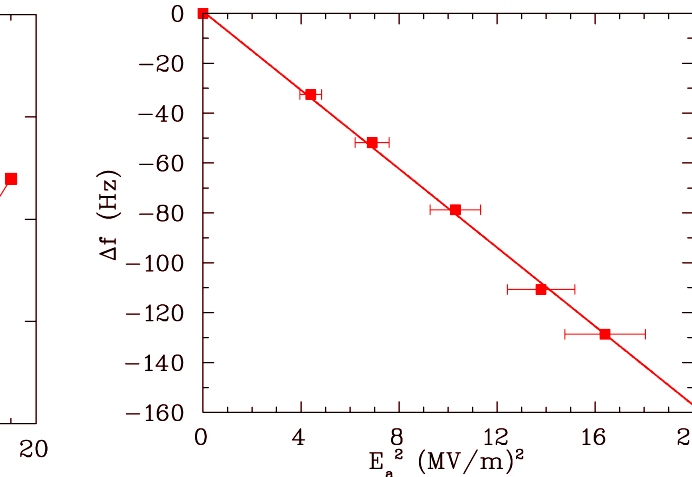
FIG. 34. (Color) Maximum gap voltage amplitudes as achieved during the test